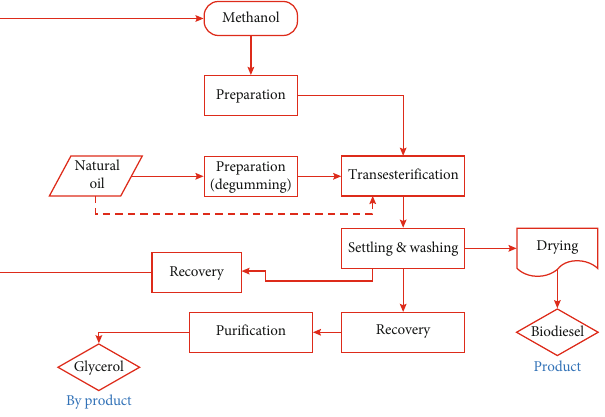
Figure 2: General fl owchart of the transesteri fi cation